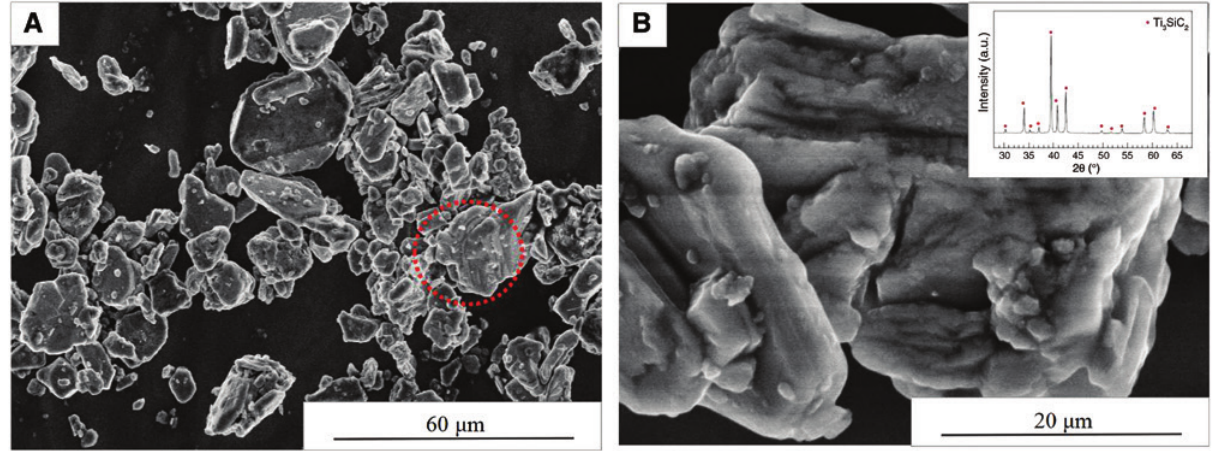
SiC particles under (A) low and (B) high magnification. 3 2